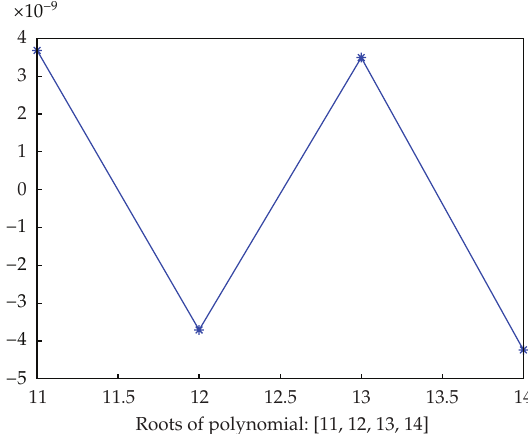
Figure 3: Error of R-Fiedler’s method for polynomial of degree 4.